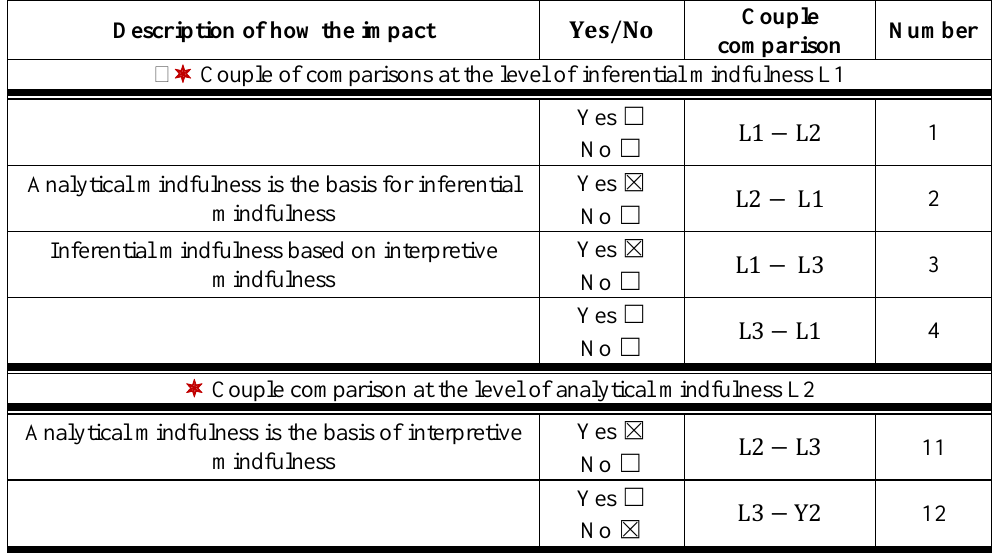
Table 9. Comparison of pairs of themes of power domination Description of how the impact